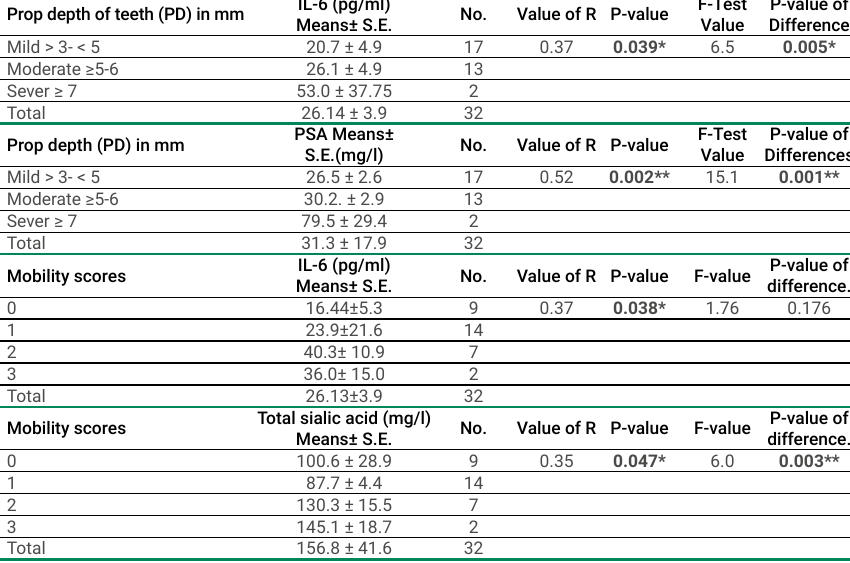
Table 3. Association of IL-6 and sialic acid with probe pocket depth and teeth mobility in periodontitis IL-6 (pg/ml) Prop depth of teeth (PD) in mm Means±